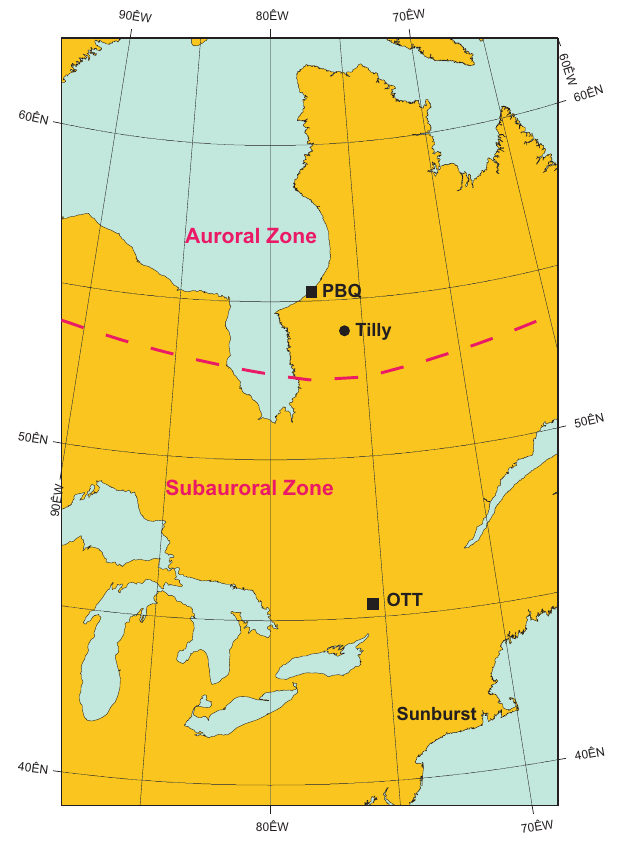
Fig. 1. Locations of ground stations used in this study. PBQ (Poste- de-la-Baleine) and OTT (Ottawa) are magnetic observatories op- erated by the GSC (Geological Survey of Canada). Tilly power substation is operated by Hydro Qu´ebec, and the GIC recording is part of the Sunburst project sponsored by EPRI (Electric Power Re- search